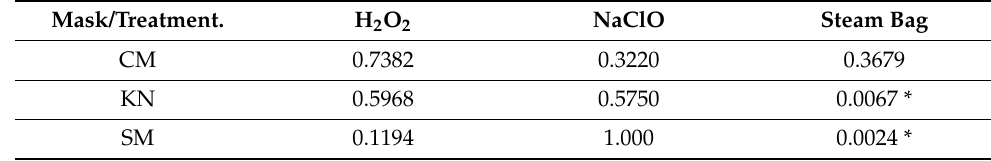
Table 1. One-way analysis of filtration efficiency (non-parametric, two-tailed Kruskal–Wallis using ranks). This statistical test was conducted for each combination of RPD (CM, KN, SM) and decon- tamination treatment (H 2 O 2 , NaClO, Steam Bag), i.e., in a total of 9 distinct cases. The table presents the p-value obtained in each case, where the results obtained across different cycles are compared (control, 5c, 10c); the conditions across the table entries follow the same pattern as in Figure 4. The software used was JMP ® PRO ver. 15.0, from SAS Institute Inc.). Statistically significant differences (significance level of 5%) are signalled with an asterisk